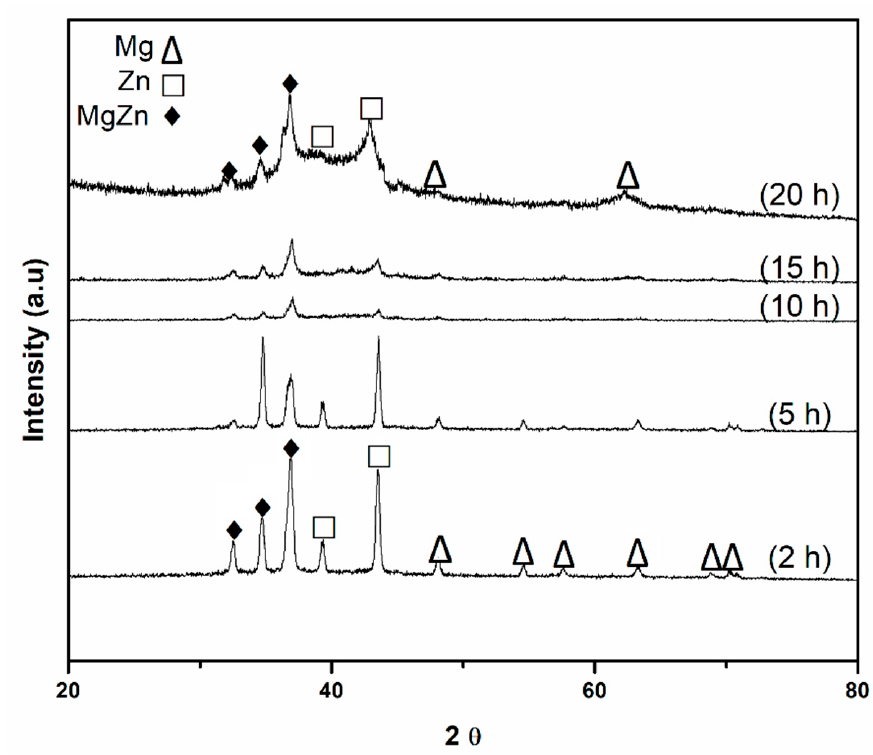
Figure 6. XRD patterns of Mg65–Zn30–Ca5 mechanically alloyed for milling times of 2, 5, 10, 15, and 20 h.